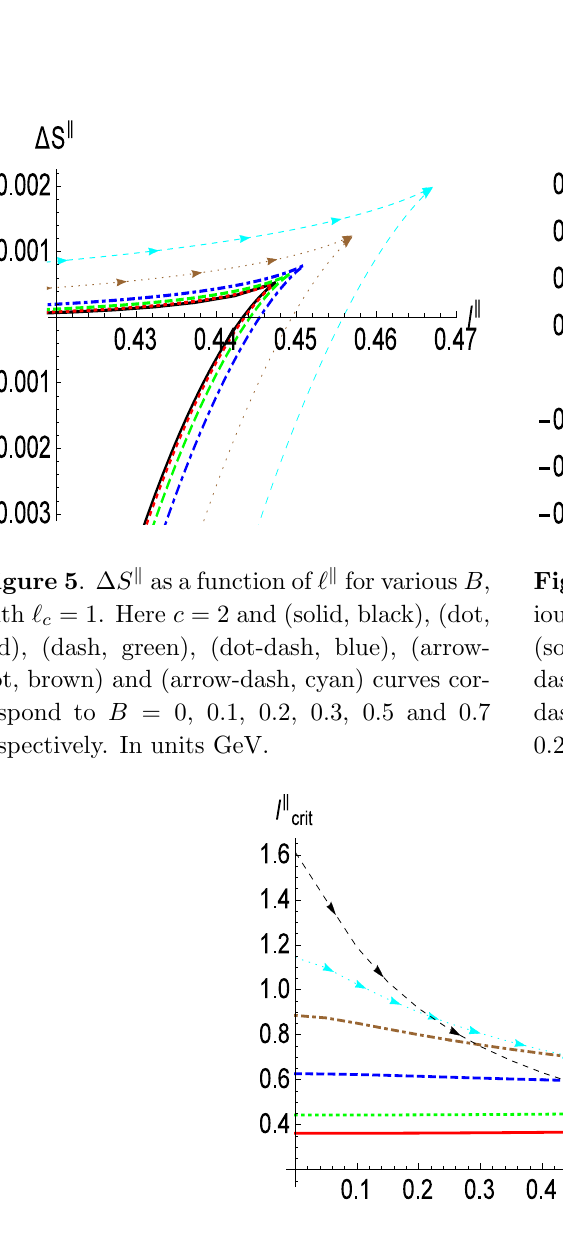
Figure 7 . ‘ k as a function of B for various c . Here ‘ c = 1 and (solid, red), (dot, green), (dash, crit blue), (dot-dash, brown), (arrow-dot, cyan) and (arrow-dash, black) curves correspond to c = 3, 2, 1, 0 : 5, 0 : 3 and 0 : 15 respectively. In units